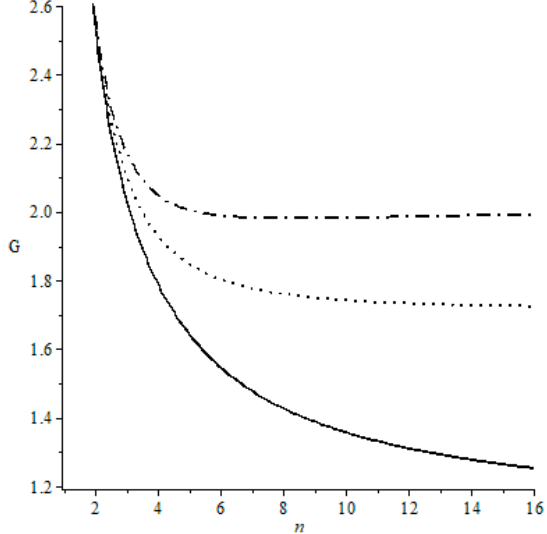
Figure 3. The growth factor depending on the number of oligopolists in a market. The growth factors differ again regarding the value of B like in Figure 2, but here a bigger value of α (=0.4) is